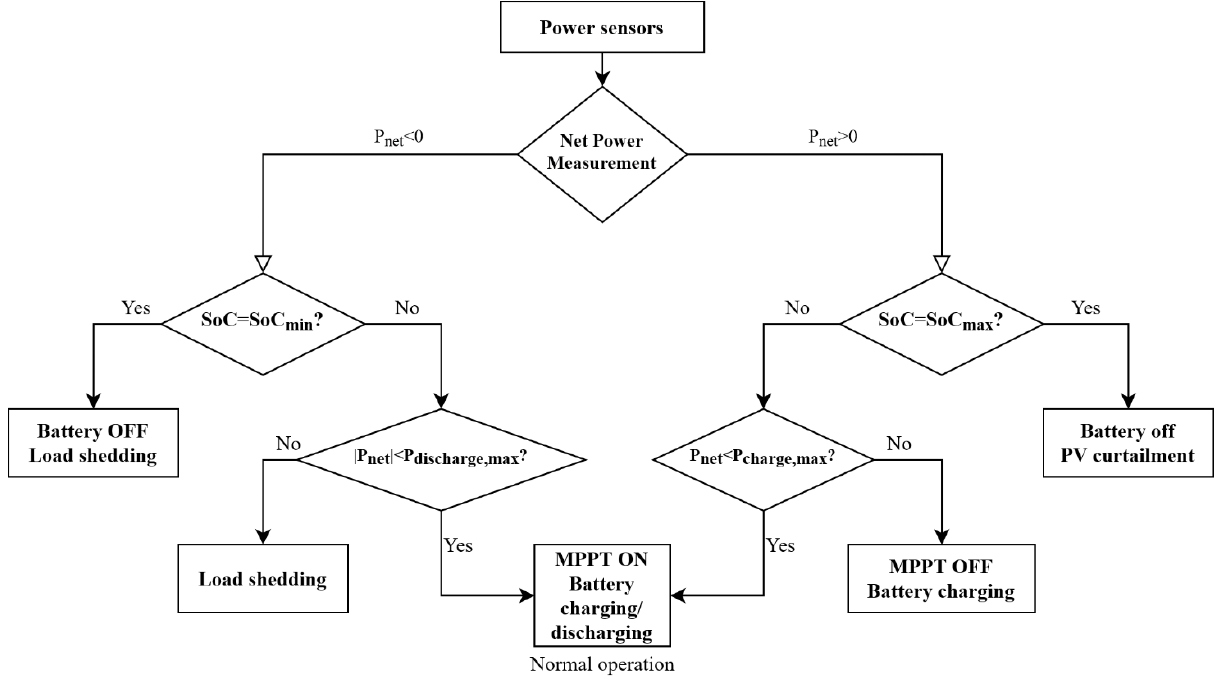
Figure 3. Energy management overview of the electrical